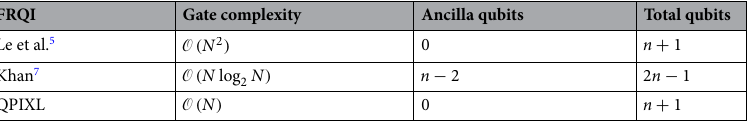
Table 1. Summary of gate complexities and qubit count for preparing the FRQI state 2 n pixels with the approaches of Le et al. 5 and Khan 7 compared to our method. N =